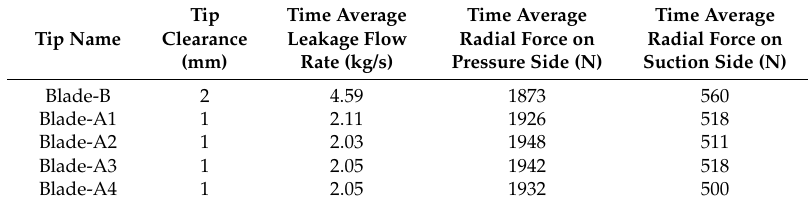
Table 4. Leakage flow rate for 5 unsymmetrical tip clearances in an impeller.